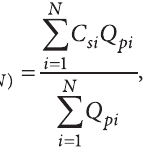
Type of section